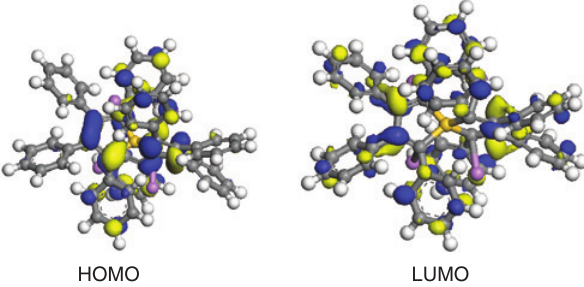
Figure 3: The calculated HOMO and LUMO of 2